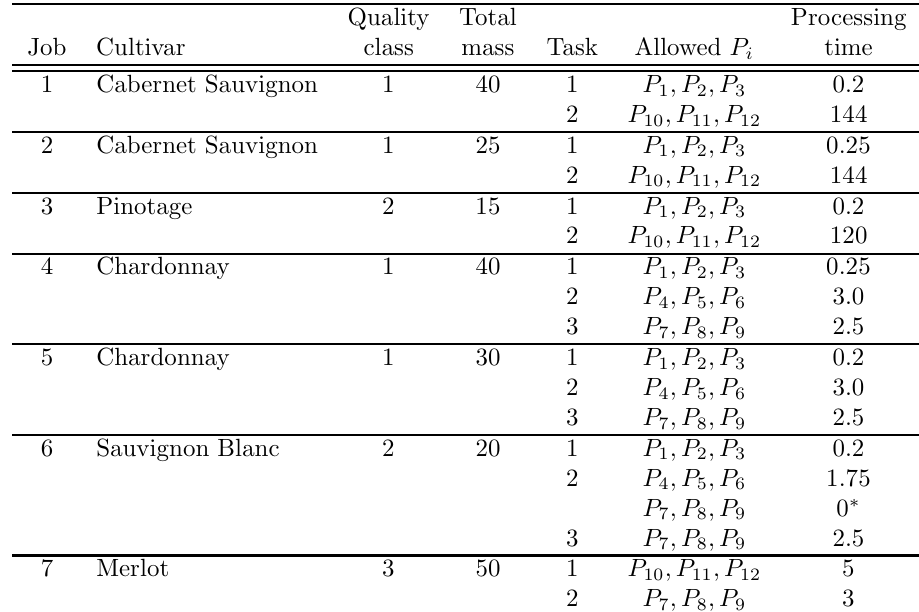
Table 1: Allowable processors and corresponding processing times (measured in hours) for a set of seven jobs in a hypothetical cellar. Job masses are specified in tonnes (entire vineyard blocks). ∗ Chardonnay grapes require some time to lie with their skins before separation and therefore the Chardonnay grapes can only be separated in a separator, whereas Sauvignon Blanc grapes may be separated in a press or